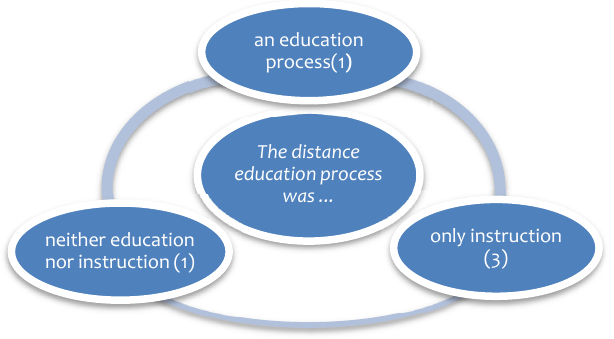
Figure 1: Opinions on the evaluation of the process as education or